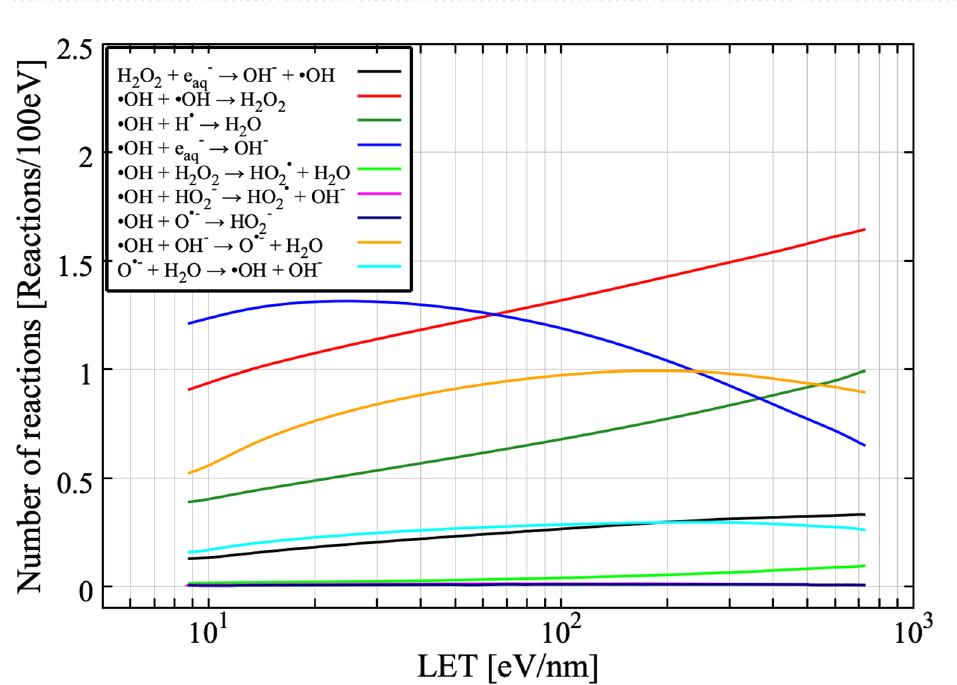
Figure 5. LET dependent number of reactions involving the · OH at 1 μs after irradiation of a water target with C ions with a LET range of 10 eV/nm to 700 eV/nm. The number of reactions is the cumulative number of reactions up to 1 μs after